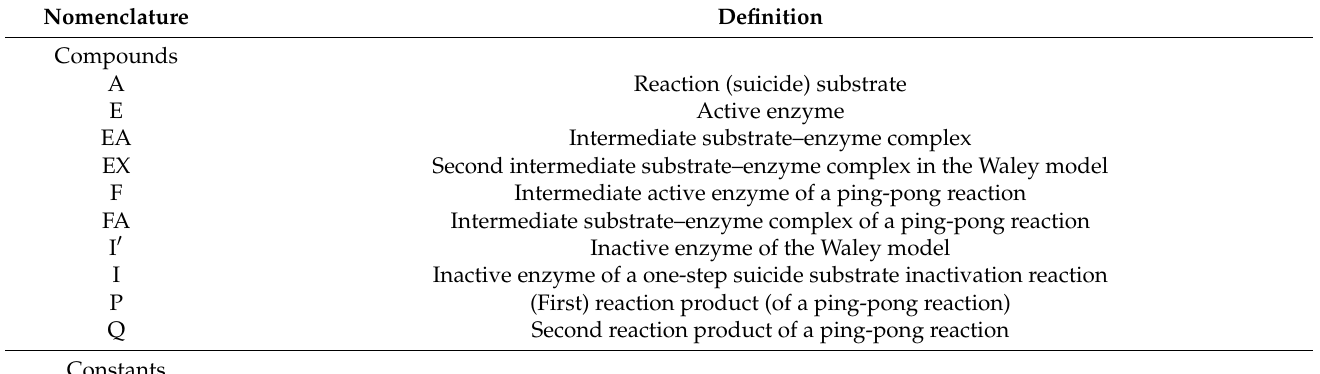
Table 1. Nomenclature and symbols for the description of the uni–uni and ping-pong